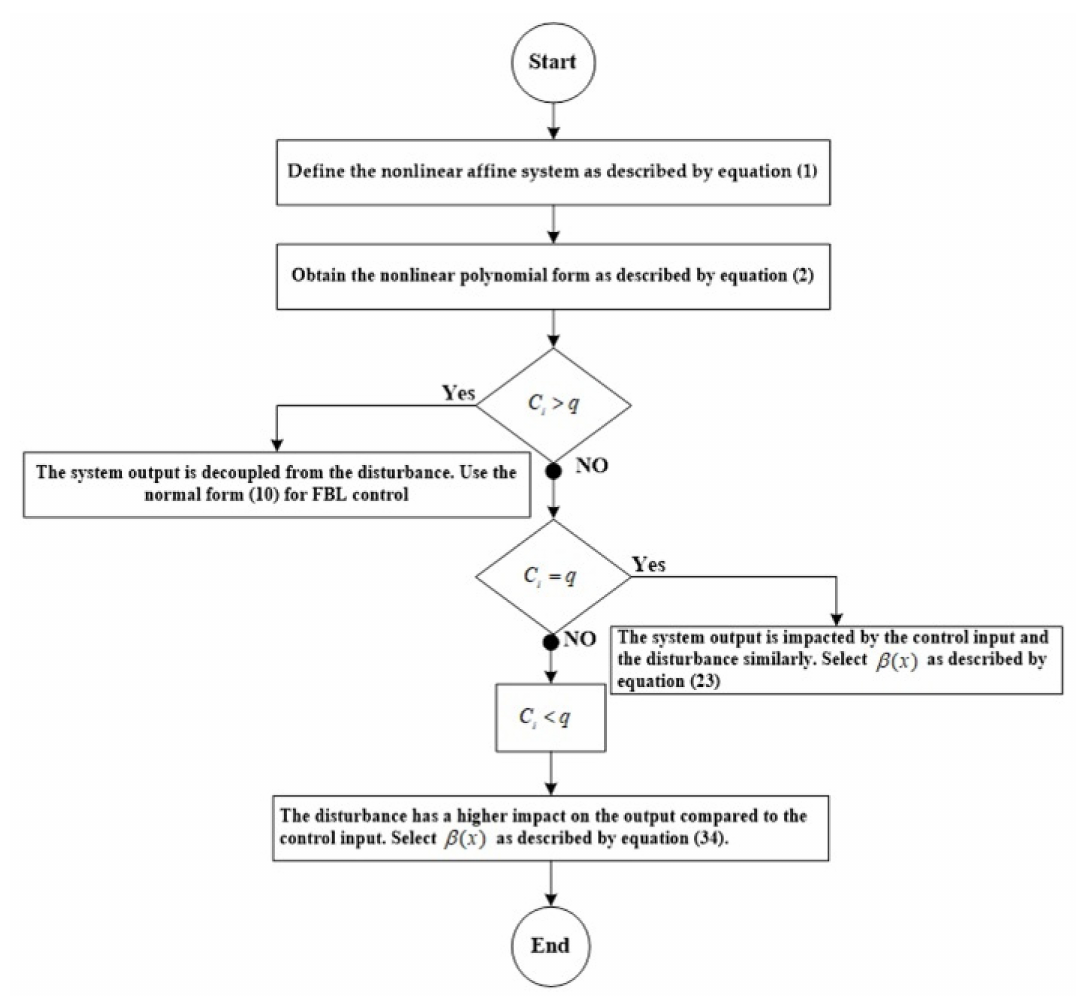
Figure 1. Flowchart for the determination of the function β ( X )